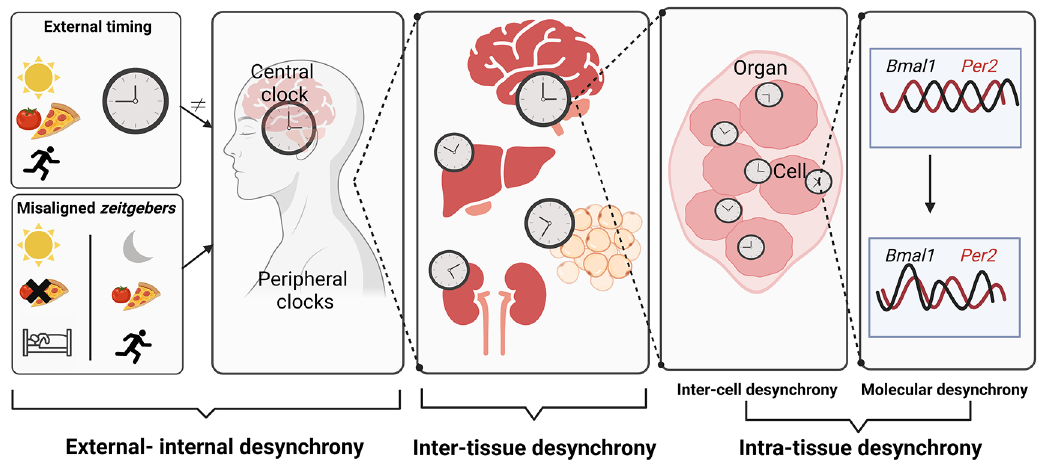
Figure 2. Different levels of circadian desynchrony. Misaligned zeitgebers like artificial lighting conditions, mistimed food intake, or activity in the rest phase create dissonance between the internal circadian timing system and geophysical time – a state somewhat vaguely termed as chronodisruption. Desynchrony of circadian rhythms can occur at various levels – from misalignment of internal and external time (as during jetlag) to alterations in the coordination of different clock gene expression rhythms at the cellular level. It is still poorly understood how the different levels of circadian desynchrony contribute to the adverse health effects of chronodisruption. Figure created with